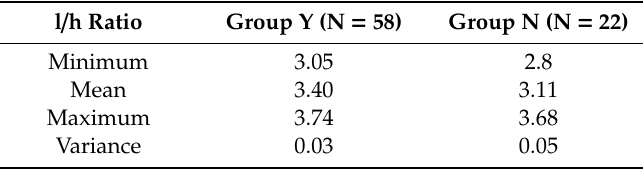
Table 4. Maximal cranial length (l) to height (h) ratio.